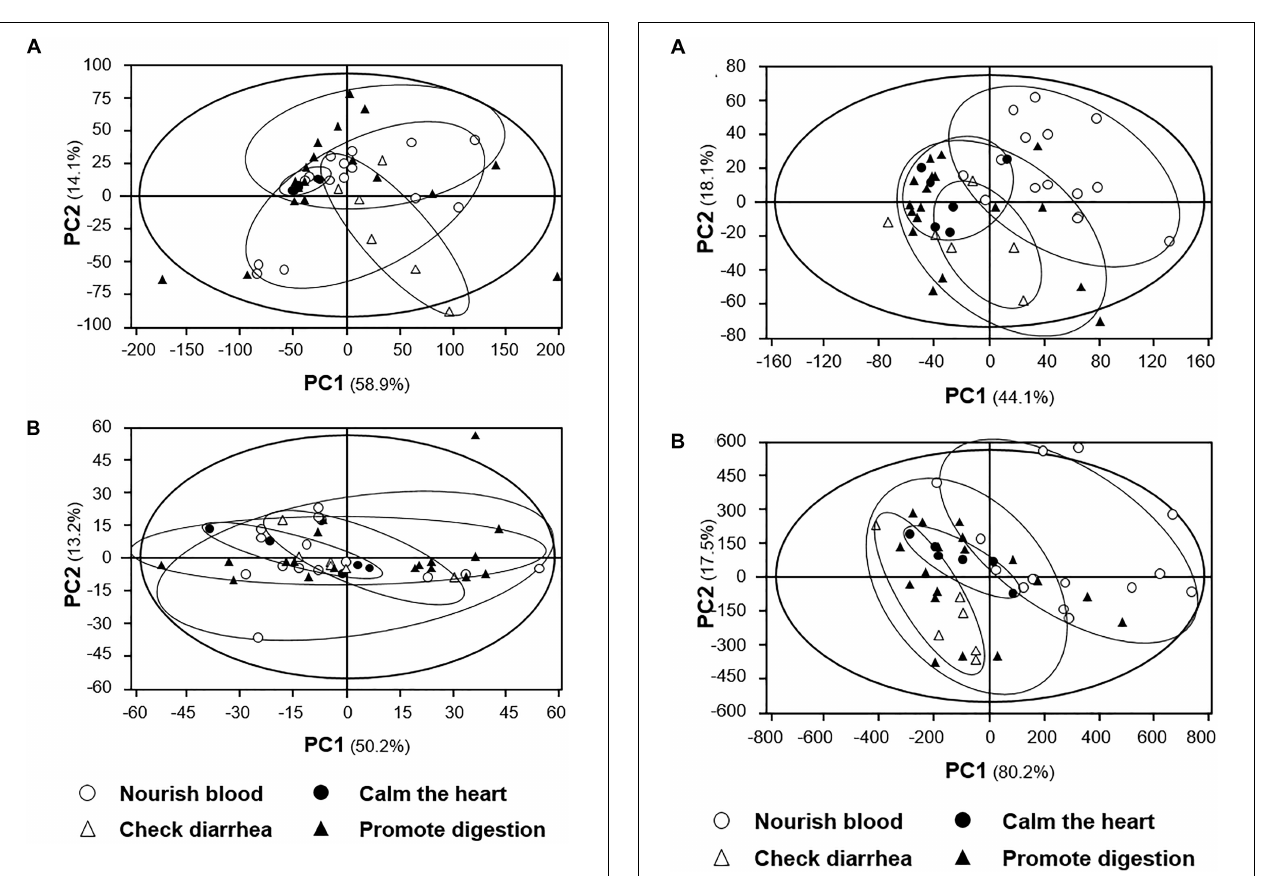
FIGURE 6 | PCA analyses of (A) HPLC and (B) 1 H NMR profiles of signals from the 15 spleen-meridian herbs. The distribution of each herbal extract in score scatter plots was calculated according to its correlation with the major components. The classification of herbal extracts was according to the proposed pharmacological activity, as described in TCM practice. The results showed very low discrimination between different types of herbal extracts.